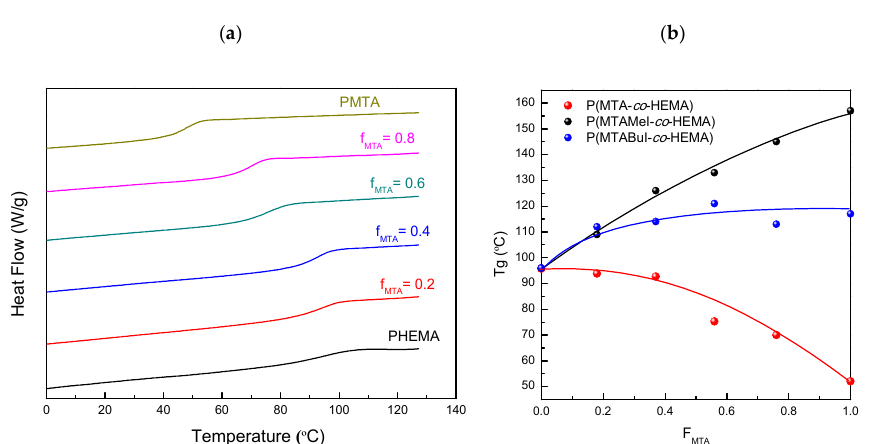
Figure 4. ( a ) Differential scanning calorimetry (DSC) curves of the pristine (PMTA- co -HEMA) copolymers; and ( b ) The glass transition temperatures of the P(MTA- co -HEMA), P(MTAMeI- co -HEMA), and P(MTABuI- co -HEMA) copolymers as a function of the MTA or MTARI content in the copolymer, F MTA